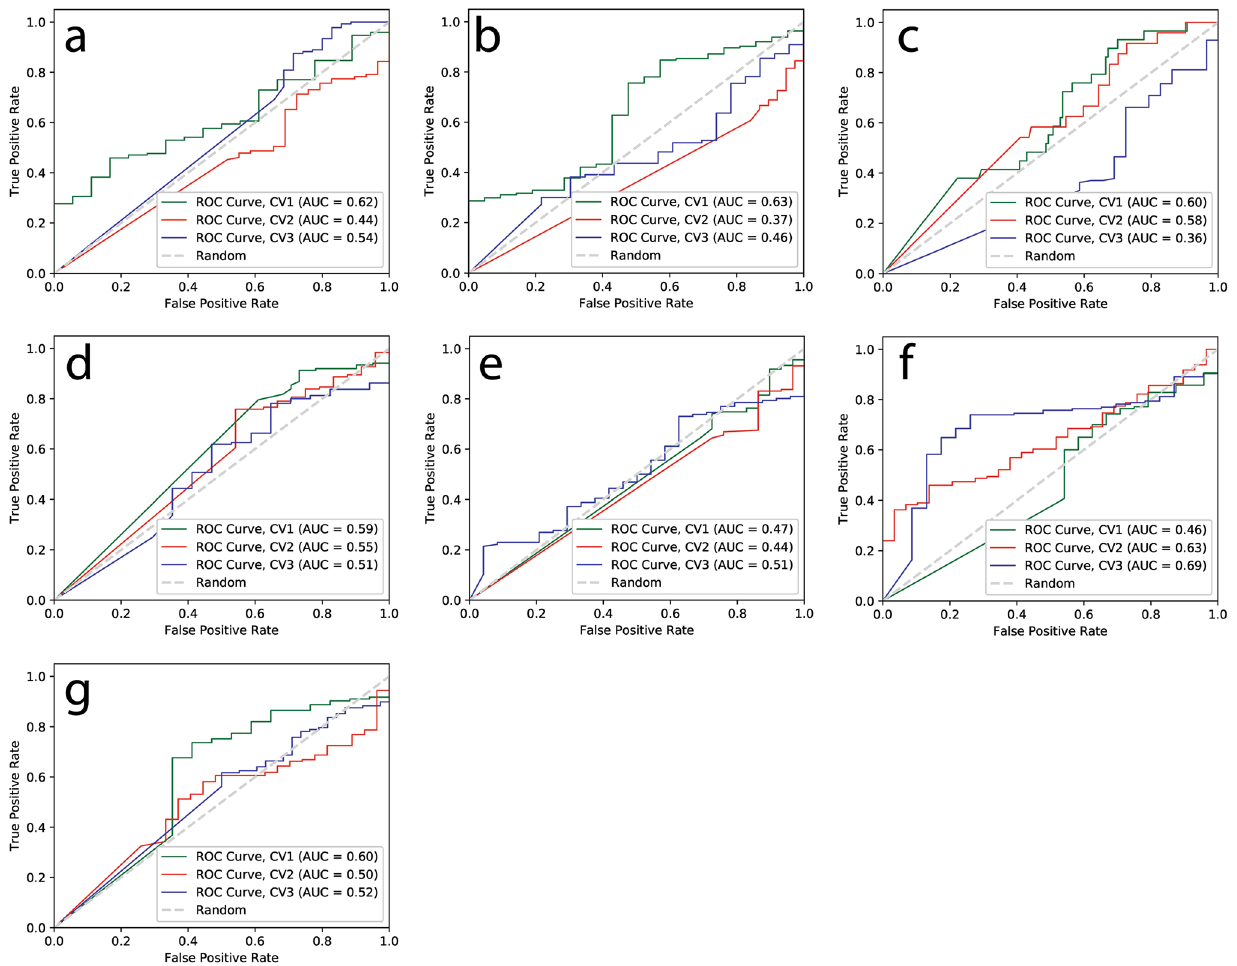
Figure 1. ROC curves for VGG16 deep learning models with each MRI sequence for prediction of PsP from TP. Each ROC curve for each modality obtained from threefold cross-validation (CV1, CV2, and CV3). The x-axis is the true negative rate (TNR) or specificity and the y-axis is true positive rate (TPR) or sensitivity. The mean AUC, area under ROC curve, values were ( a ) 0.53 for pre T1-weighted, ( b ) 0.49 for post T1-weighted, ( c ) 0.51 for T2-weighted, ( d ) 0.55 for FLAIR, ( e ) 0.47 for ADC map, ( f ) 0.59 for post T1–pre T1, ( g ) 0.54 for T2– FLAIR images.